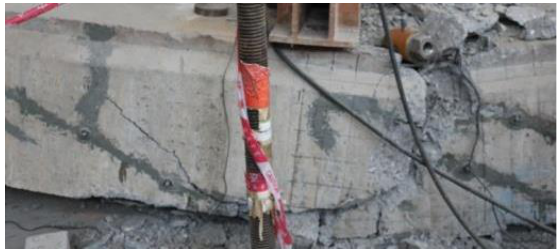
Figure 14. Nephogram of concrete stress along span of the strengthened beam under: ( a ) cracking load (0.73 P 0 ); ( b ) service load P 0 ; ( c ) ultimate load. Figure 15. Crushed concrete in compression zone of pure bending segment near loading section.